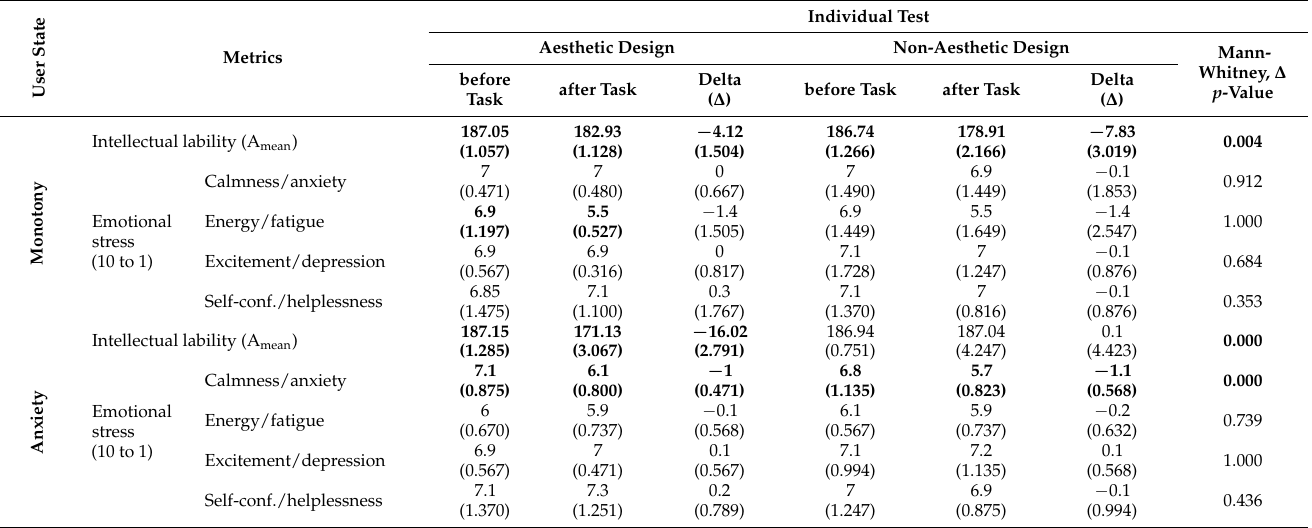
Table 3. The results of the experiment, individual testing, aesthetic vs. non-aesthetic design.